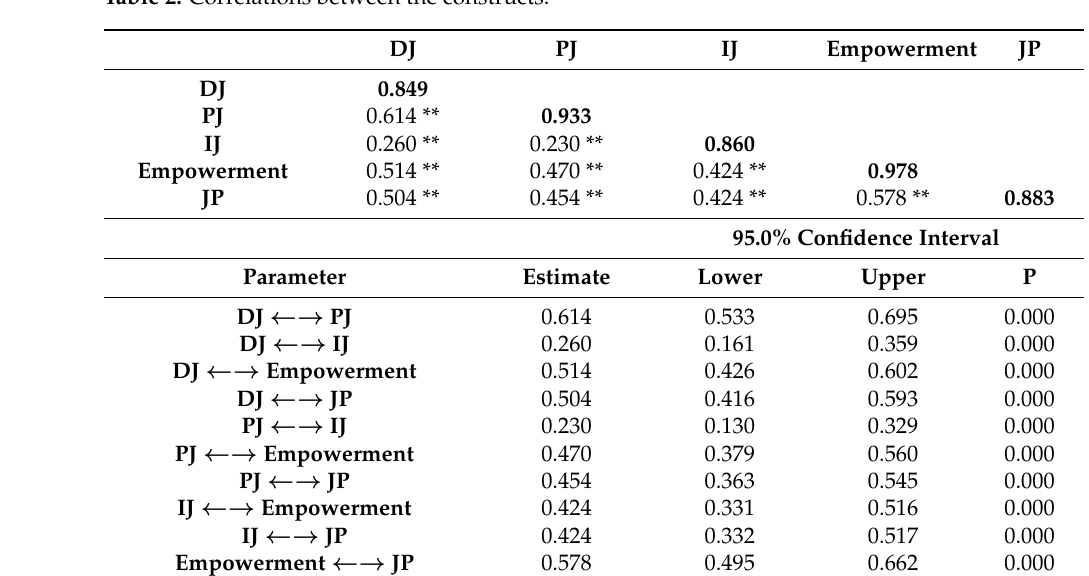
Table 2. Correlations between the